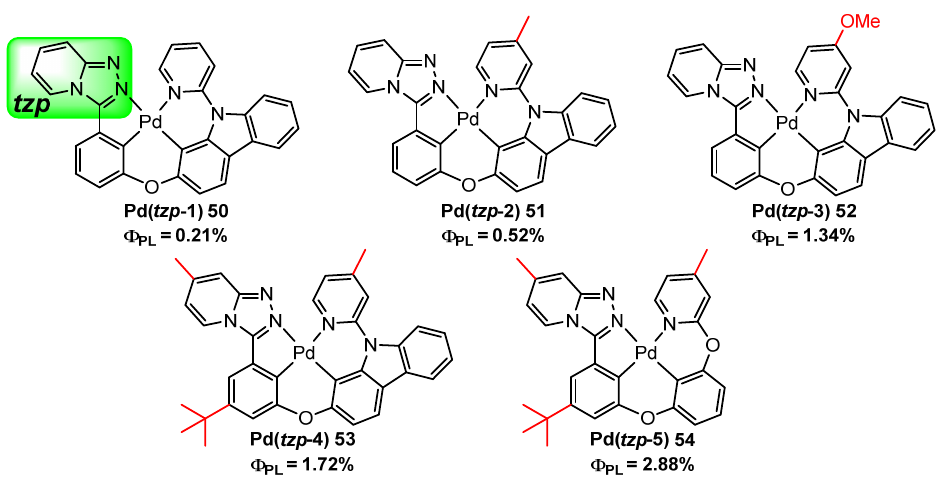
Figure 18. Pd(II) organometallic complexes 50 − 54 with tz p-type moiety. Adapted from [82]. In 2021, the group of She and coworkers [83] synthesized Pd complexes 55 and 56 containing fused 6/6/6 or 6/6/5 metallocycles with azacarbazolylcarbazole-based ligands, represented in Figure 19. Both showed efficient RISC to generate MADF and phospho- rescence in PMMA films at room temperature, where both ACz and py units behaved as acceptors, and CzPh and CzCz as donors. Charge transfer occurred through the central Pd ions. The Φ PL of 55 and 56 were relatively low due to their weak SOC effect. Complex 55 exhibited an ultralong fluorescence lifetime of up to 1307 µ s in 2-MeTHF at 77 K.